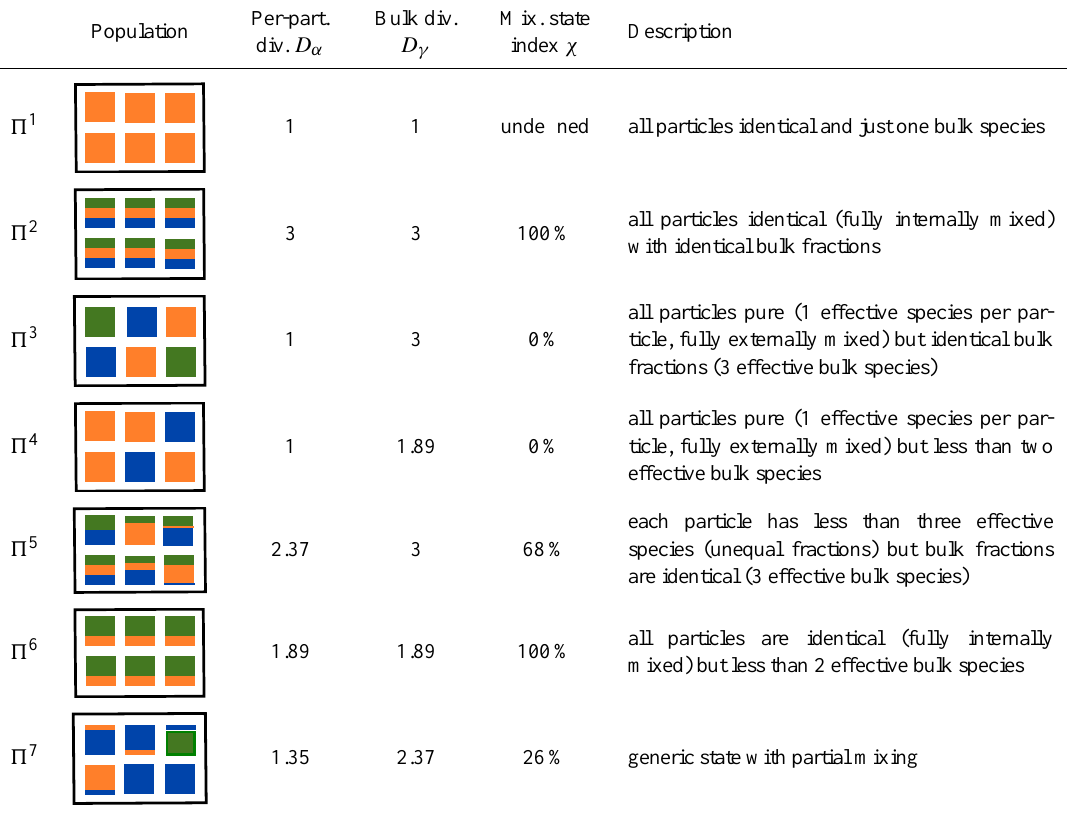
Table 4. Representative particle populations shown on Fig. 2, with the average per-particle diversity D α , the bulk population diversity D γ , and the mixing state index χ listed for each population.